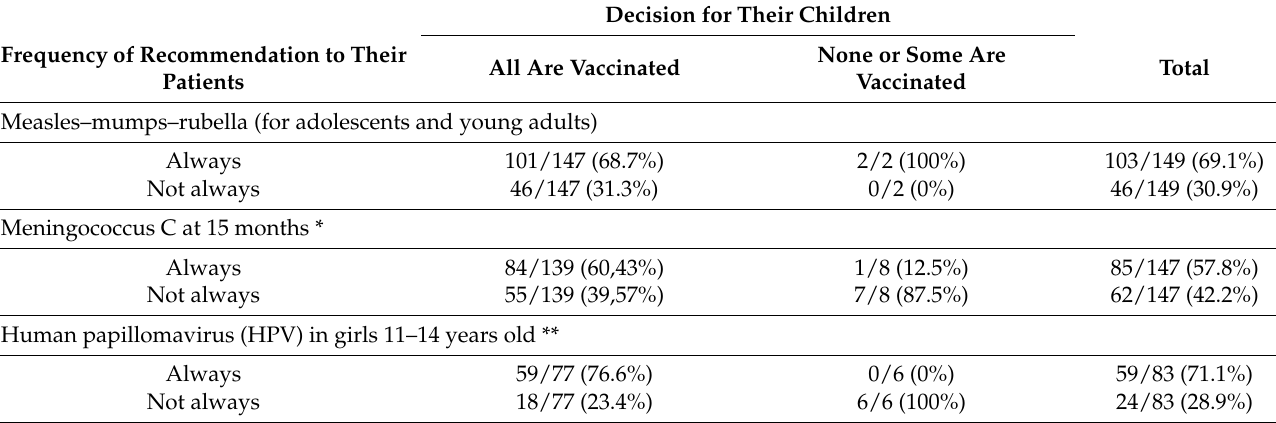
Table 4. Recommendations by general practitioners for children and their